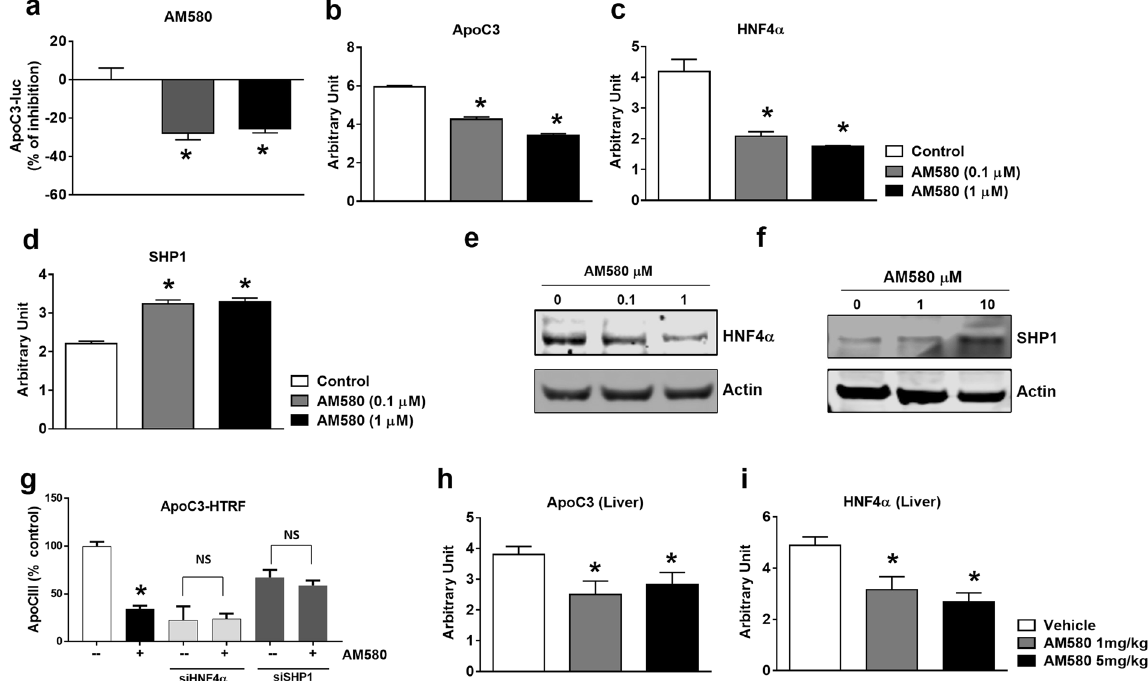
Figure 5. RAR α agonist inhibits hepatic ApoC-III expression. ( a ) ApoC-III promoter activities were measured with an ApoC-III luciferase reporter assay in HepG2 cells. ApoC-III promoter reporter stable cells were generated by transfection and selection. ApoC-III luciferase reporter activities were measured after 16 hr incubation with AM580 (0.1 and 1 μ M). mRNA levels of ApoC-III ( b ), HNF4 α ( c ) and SHP1 ( d ) and protein levels of HNF4 α ( e ) and SHP1 ( f ) in Hep3B cells. mRNA was analyzed by qRT-PCR in Hep3B cells after 16 hr incubation with AM580 (0.1 and 1 µ M) or vehicle control. Protein levels were analyzed by western blotting with anti-HNF4 α and anti-SHP1 antibodies after Hep3B cells were treated with Am580 (0.1, 1 or 10 μ M) for 24 h. ( g ) ApoC-III protein levels are regulated by HNF4 α -SHP1 axis. Hep3B cells were silenced with siHNF4 α or siSHP1 in the presence or absence of AM580 (10 μ M) and secreted ApoC-III levels at the end of day 3 were measured by HTRF assay as described earlier. Representative triplicate data is shown from at least three independent experiments. Liver mRNA levels of ApoC-III ( h ) and HNF4 α ( i ) after 9 days of treatment with AM580 (1 mg/kg and 5 mg/kg) and vehicle control. Hepatic gene expressions were measured by qRT-PCR in liver tissue after 9 days of treatment. * P < 0.05 versus control. Data are means ± S.E. of 5–8 animals per group. * P < 0.05 versus